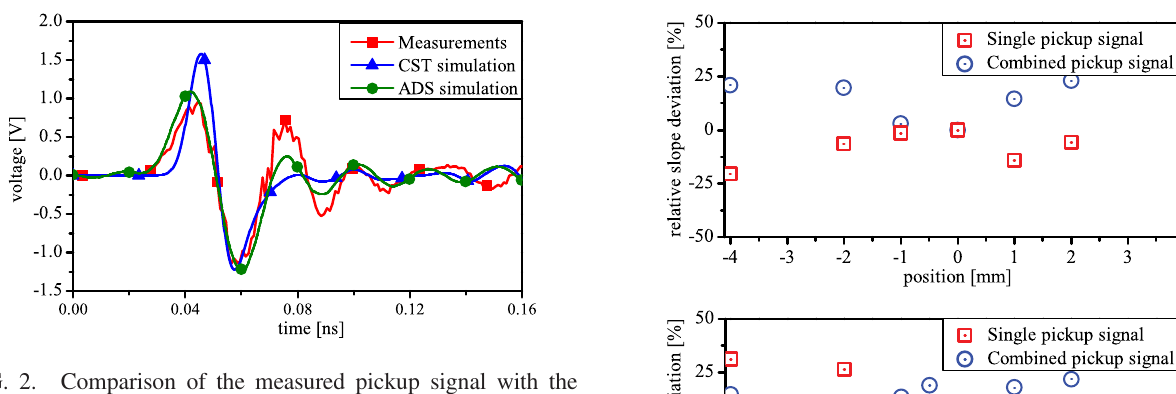
FIG. 2. Comparison of the measured pickup signal with the simulations for a bunch charge of 20 pC. The CST simulation shows the signal at the pickup output, while the ADS simulation shows the signal after the rf path.